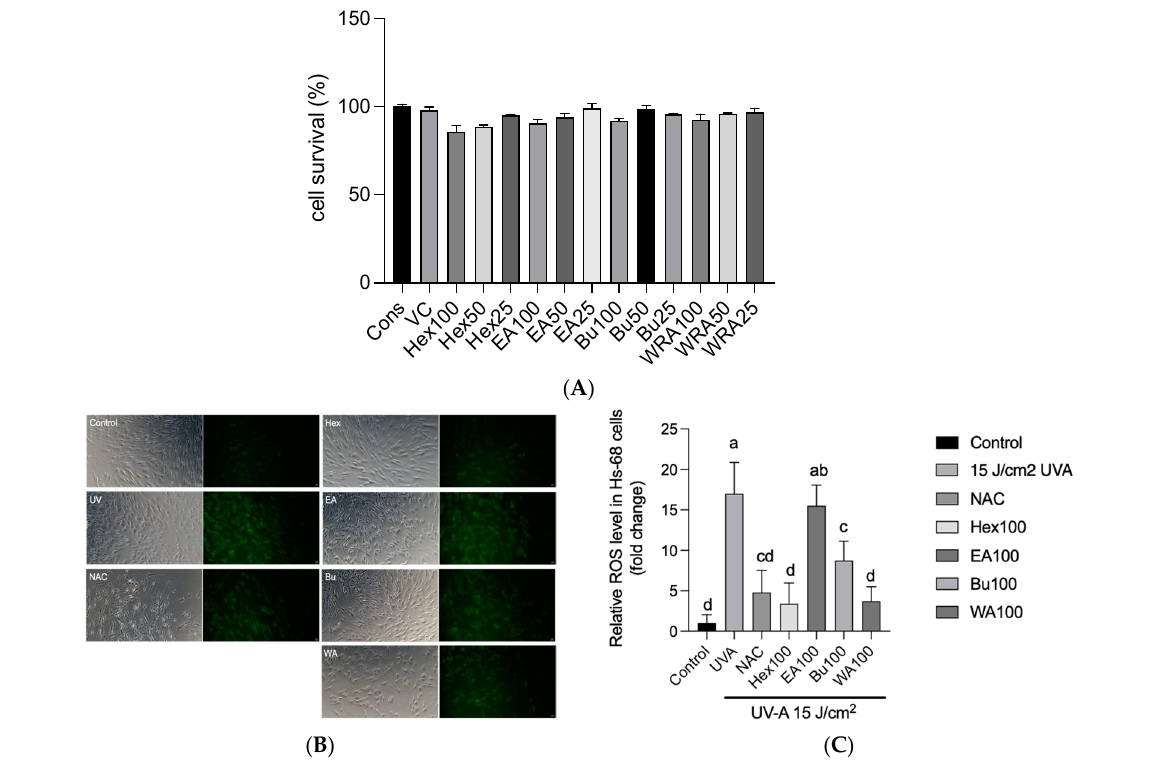
Figure 5. Effects of fermented turmeric milk from various solvent fractions on UVA-induced ROS production after UVA exposure on Hs68 cells. ( A ) Cell survival rate of the four fractions of fermented turmeric milk extracts with different concentrations in Hs68 cells. ( B ) Images of ROS production in Hs68 cells were observed under fluorescence microscopy (400× magnification). ( C ) Bar values are the mean ± SD of three replicates. Bars with different superscripts indicate a significant difference ( p < 0.05). NAC: N-acetylcysteine group. Hex100: 100 ppm of hexane fraction of fermented turmeric milk extract. EA100: 100 ppm of ethyl acetate fraction of fermented turmeric milk extract. Bu100: 100 ppm of butanol fraction of fermented turmeric milk extract. WA: 100 ppm of water residue fraction of fermented turmeric milk extract.